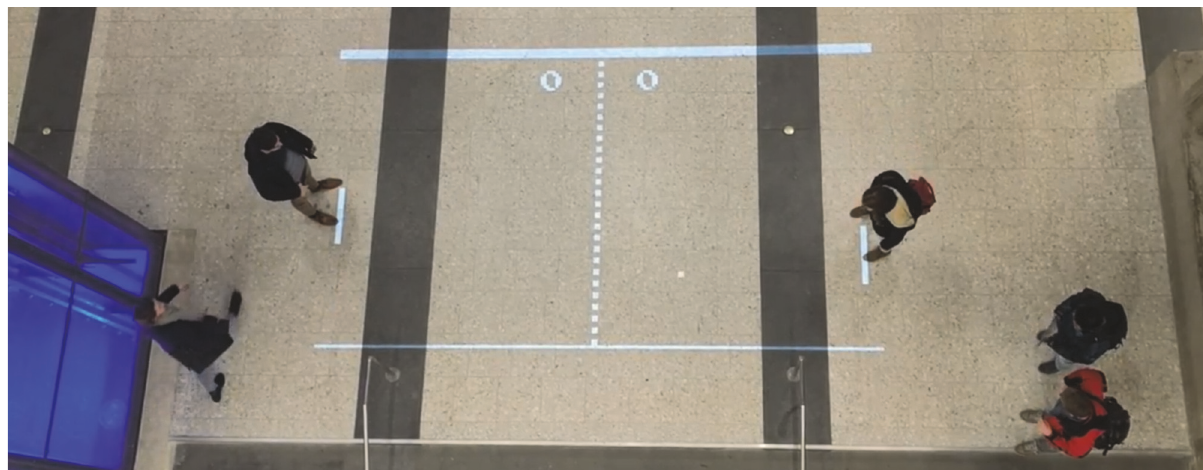
Figure 1: A group of people interacting while playing Pong in a public